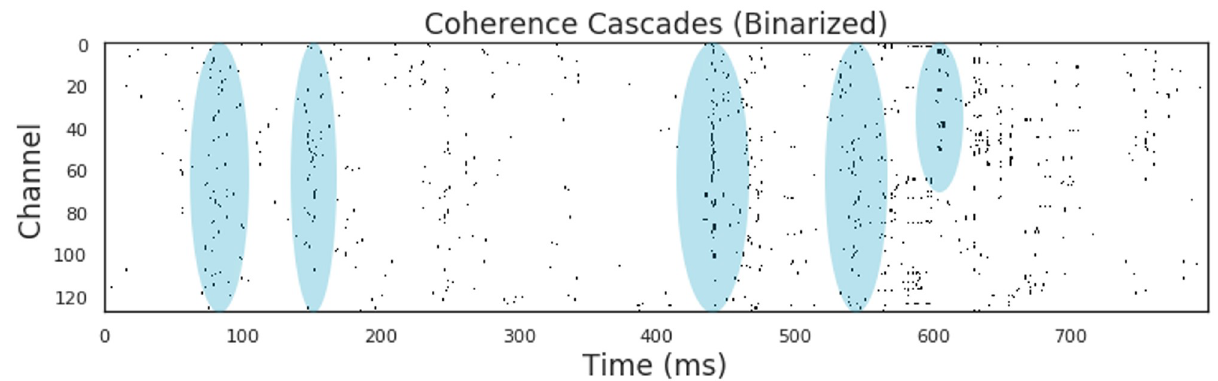
Fig 4. Coherence cascades in the awake condition. An example of a section of the raster plot. Notice the banding effect of coherence cascades (a few examples are highlighted by blue ovals). This banding effect shows the cascades of events that include many distinct channels that “fire” in synchrony.